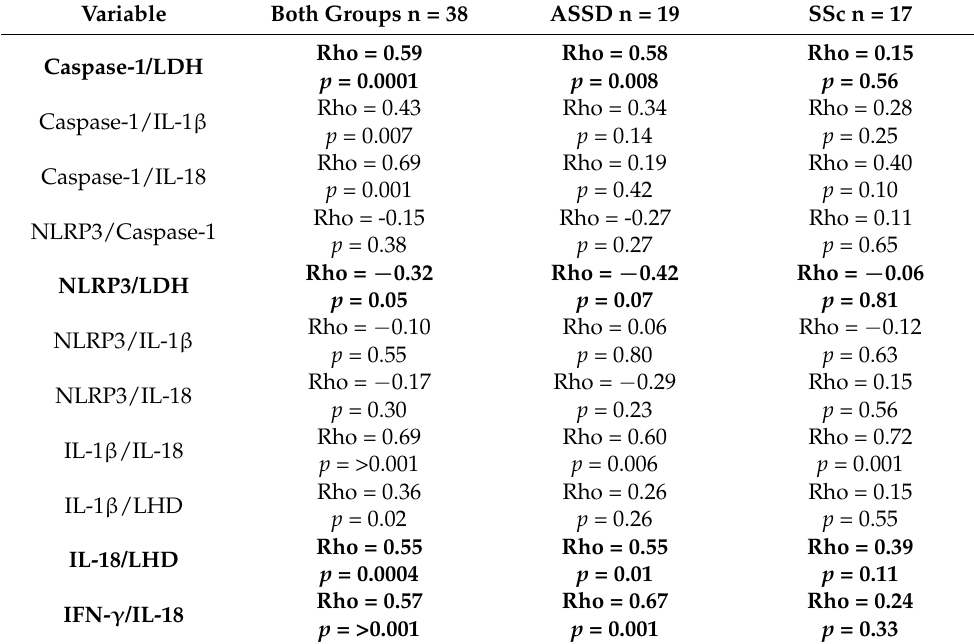
Table 4. Correlation between proteins and molecules related to the inflammasome pathway.